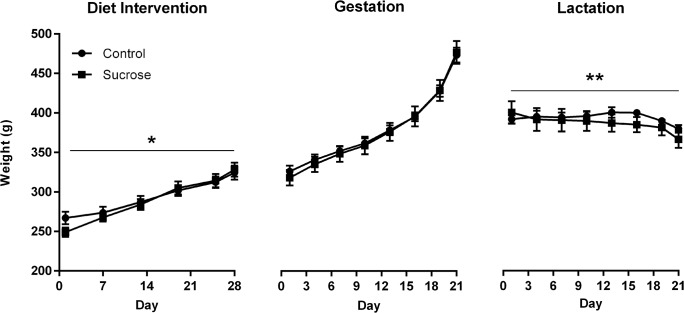
Body weights of female rats across the diet intervention, gestation, and lactation.Rats in the Sucrose group had free access to 10% sucrose solution during the 28-day diet intervention and during gestation, with access ceasing at parturition (P). Data are group means ± SEM, with n = 12 for the diet intervention phase and n = 11 for gestation and lactation phases (1 rat from each group miscarried). Relative to Controls, the Sucrose group gained a greater proportion of starting body weight during the diet intervention, *p = .02, and lost a greater proportion of weight during lactation, **p = .003. Groups did not differ in the rate of weight gain during gestation.